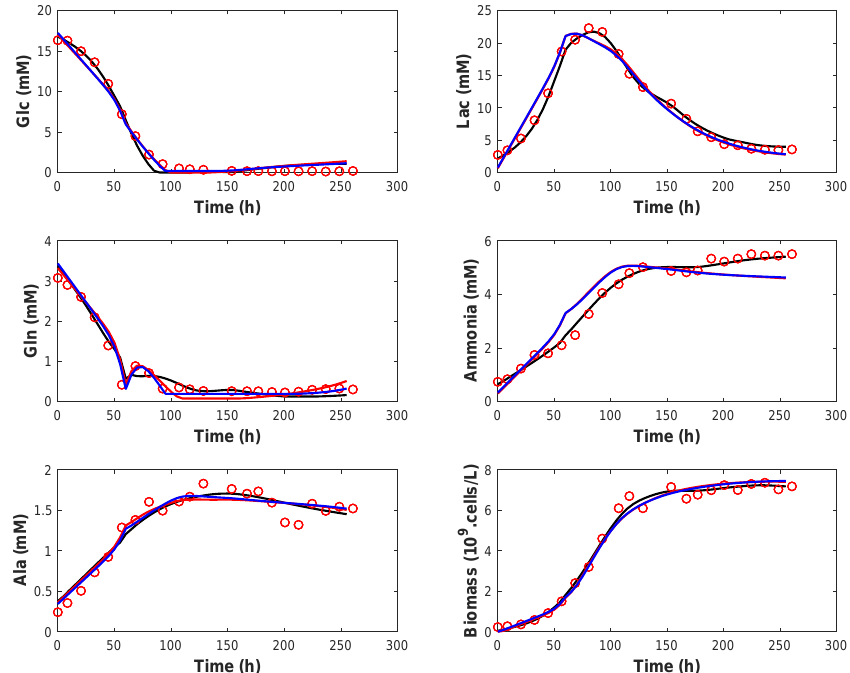
Figure 12. Prediction of the time evolution of the extracellular measured species in dataset # 2— numerical results from the reduction procedure before kinetic identification (black curves); MLP with three neurons in the hidden layer and nonlinear re-identification of the parameters (red curves); pruned MLP with three neurons (blue